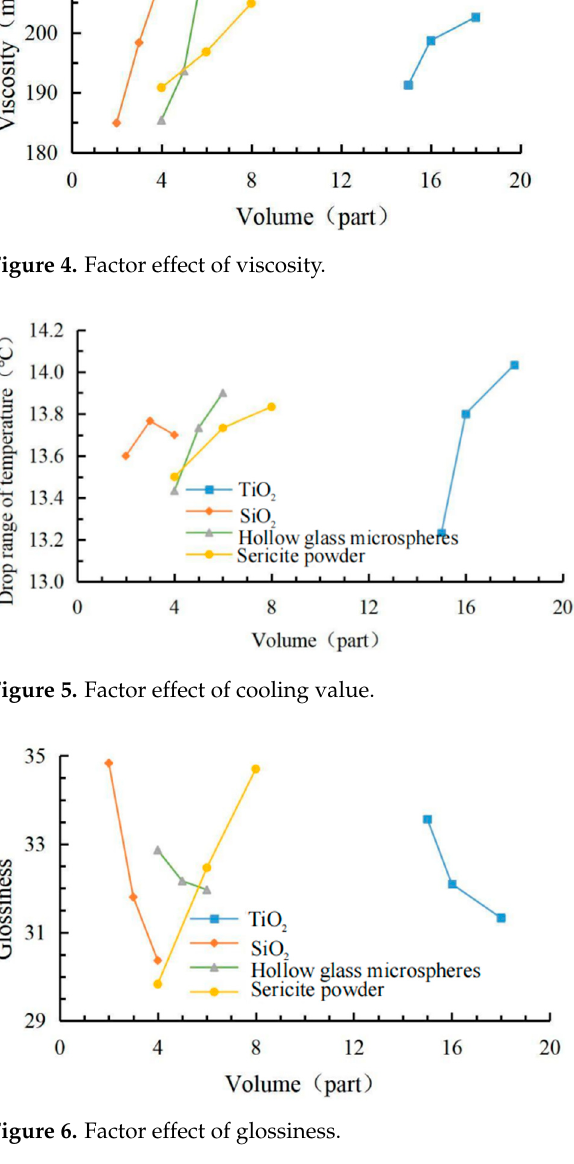
Figure 6. Factor effect of glossiness.